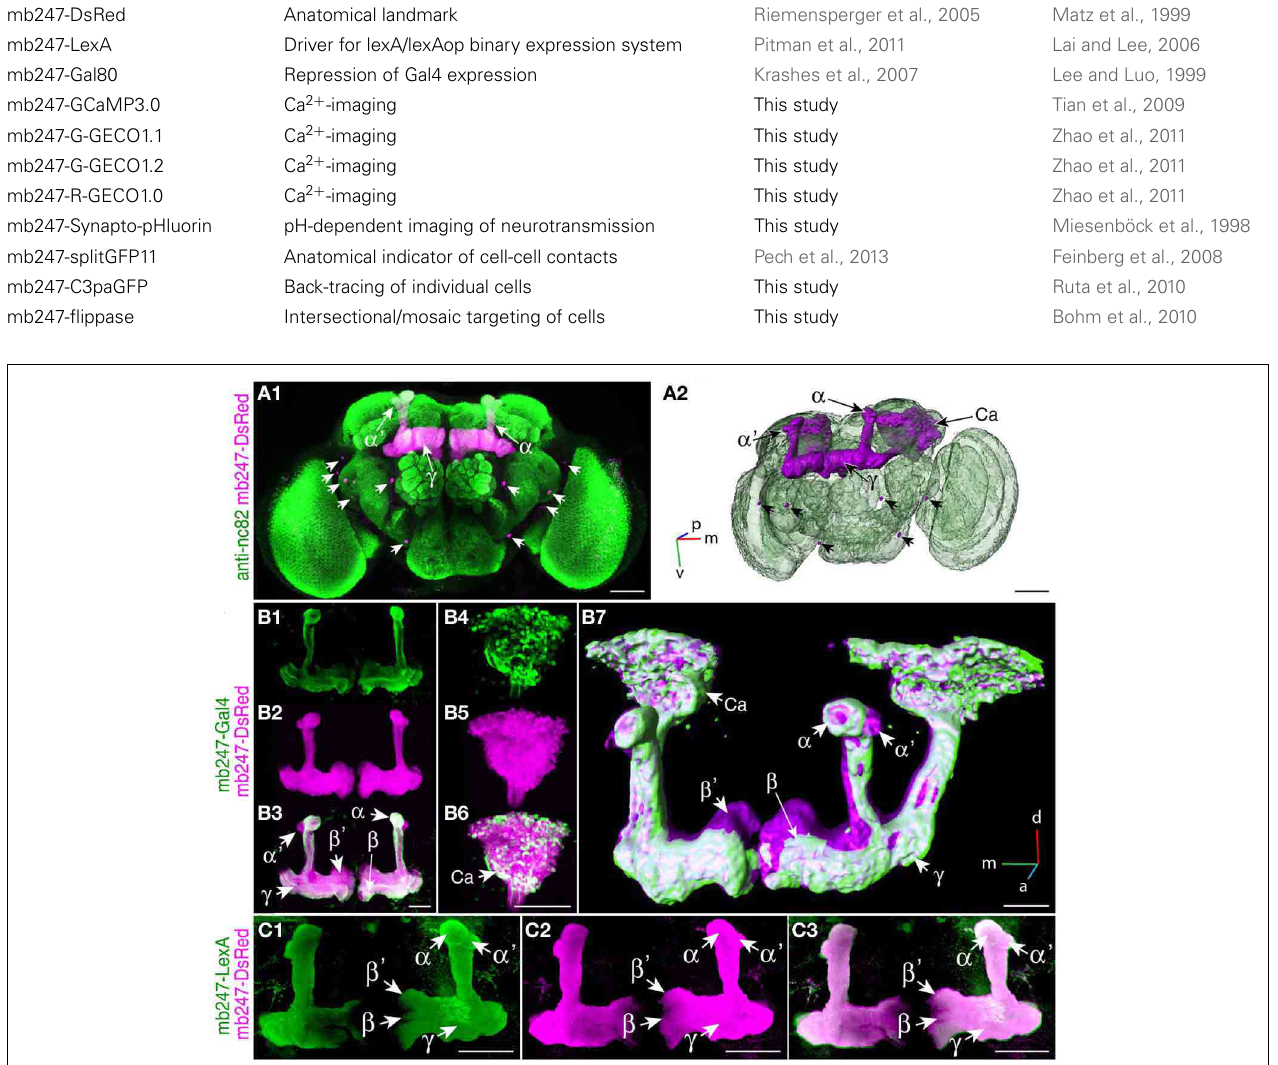
FIGURE 1 | Targeting the Drosophila mushroom body using a duplicated mb247 promoter construct. (A) Expression of DsRed in the mushroom bodies of a Drosophila brain (frontal view, A1 ). Expression in neurons outside the mushroom body is indicated by arrowheads. Neuropils are stained using an anti-bruchpilot-antibody (green) and the DsRed expression is shown in magenta. (A2) 3D reconstruction of the brain depicted in (A1) . (B) Expression of mcd8-GFP under control of mb247-Gal4 is mainly confined to the α / β - and γ -lobes (B1) . (B2) On the contrary, DsRed expression under control of the duplicated mb247 promoter is visible also in the α (cid:3) / β (cid:3) -lobes. (B3) Overlay of